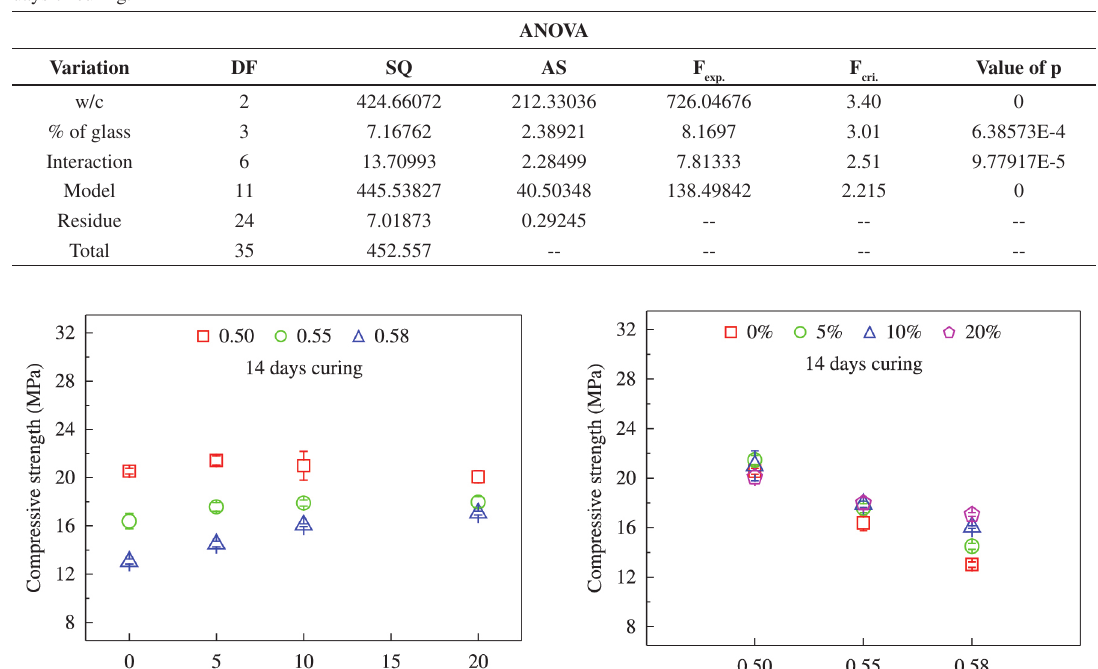
Table 5. ANOVA values of the compressive strength test to determine the effects of the w/c ratio and waste glass percentage after 28 days of curing.